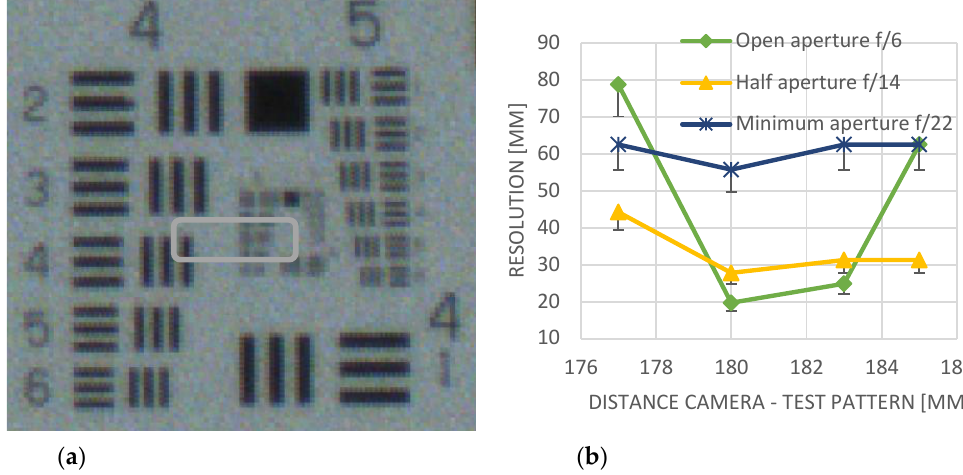
Figure 5. ( a ) Detail of the USAF 1951 test pattern with f/6 aperture. In the best case, the lines of the fifth element of the fifths group (box) can be separated, giving a spatial resolution of 19.7 µm. ( b ) Resolution with respect to aperture and working distance.